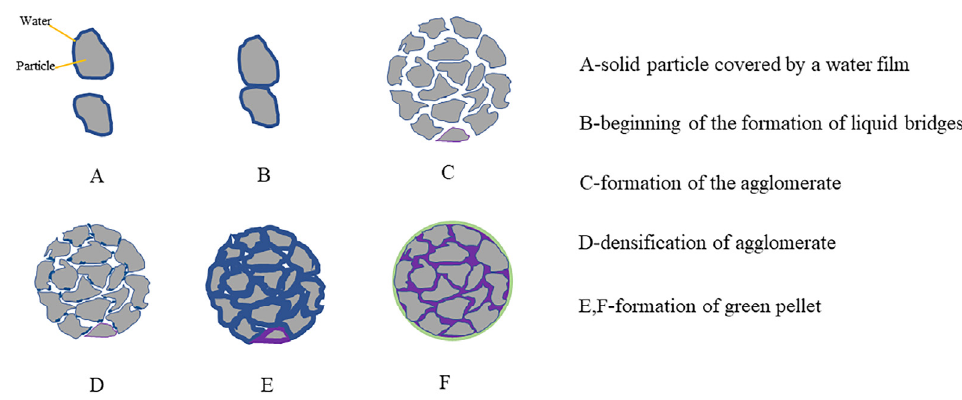
Figure 2. The steps in the formation of green pellets